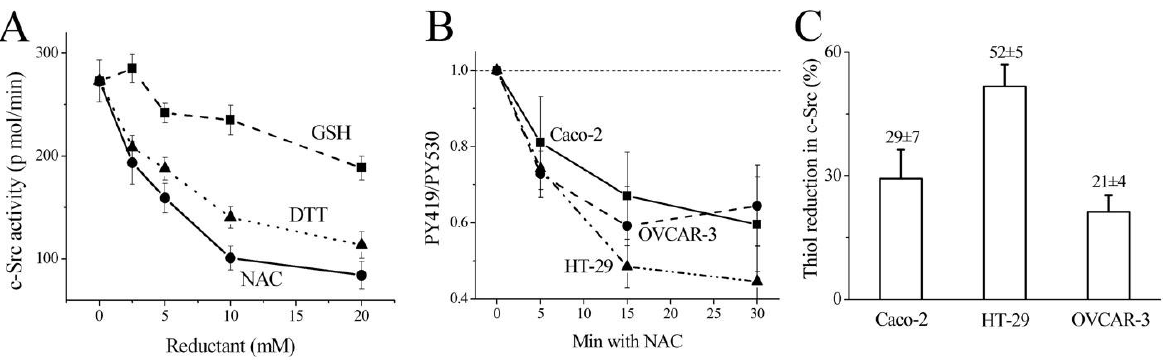
FIGURE 1 . NAC reverted c-Src activation. (A) The activity of purified c-Src was analyzed as the phosphorylation rate of a specific substrate peptide and was found reduced in a dose-dependent fashion by NAC, DTT, and GSH. (B) The phosphorylation of Tyr419 and Tyr530 in c-Src was measured in cells incubated in the presence of NAC by Western Blot. Tyr530 phosphorylation was either unaffected or slightly increased, so that when reporting the Tyr419/Tyr530 ratio, the effect of NAC is quite clear. In all cells, the PTyr419 decreased up to approximately 30% after 30 min in the presence of NAC. (C) Increased accessibility to BIAM labeling, a selective probe of reduced thiols in cysteine, in c-Src immunoprecipitated from the three cell lines after 15 min from NAC treatment. A and C are redrawn from Krasnowska et